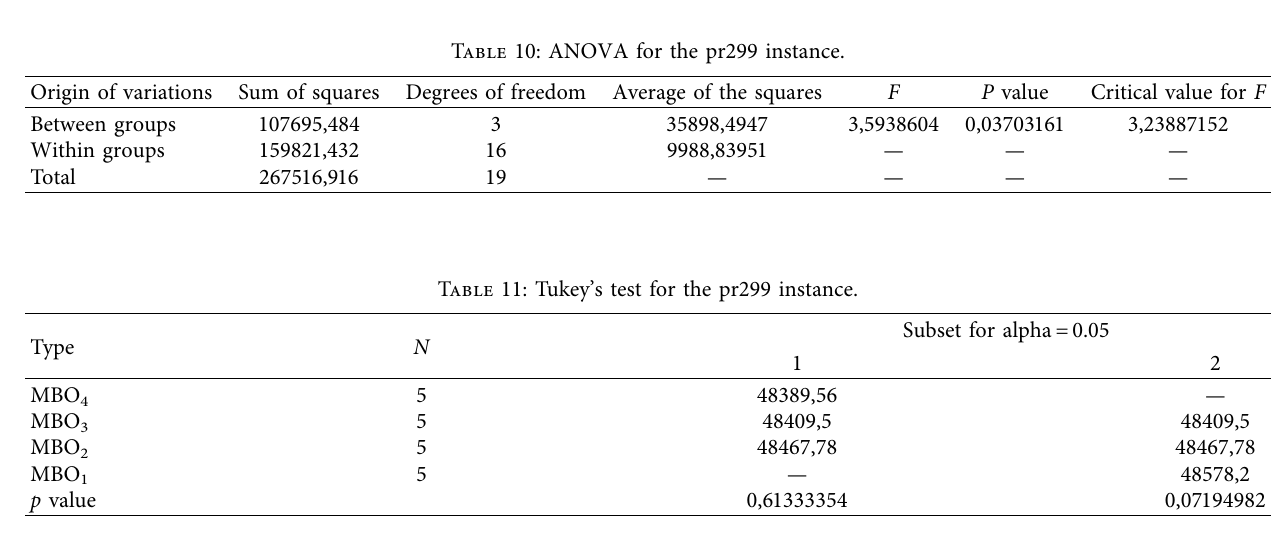
Table 10: ANOVA for the pr299 instance.